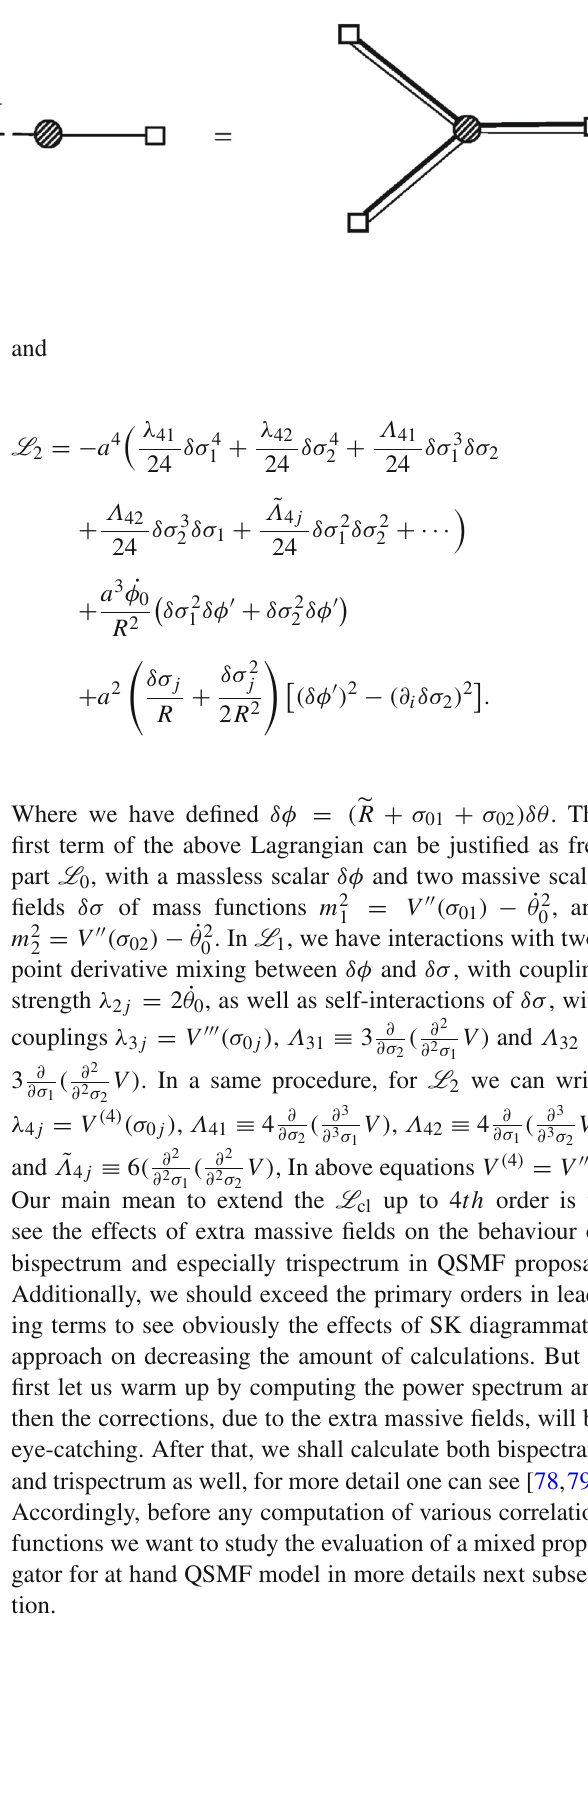
Fig. 1 In this diagram the solid lines express the propagators of massless field δφ while dashed lines represent the propagator of massive fields δσ i , and i refers the different components of these